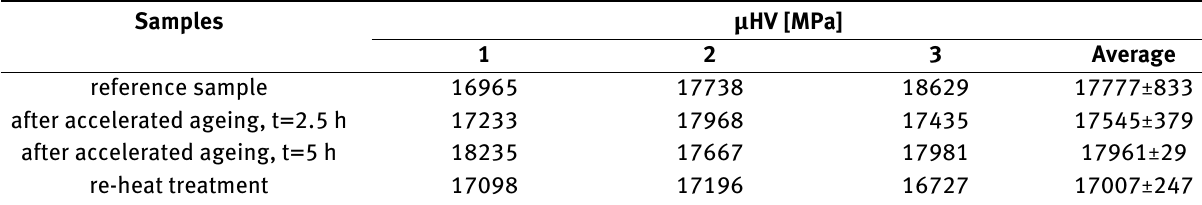
Table 6: Vickers hardness measurements